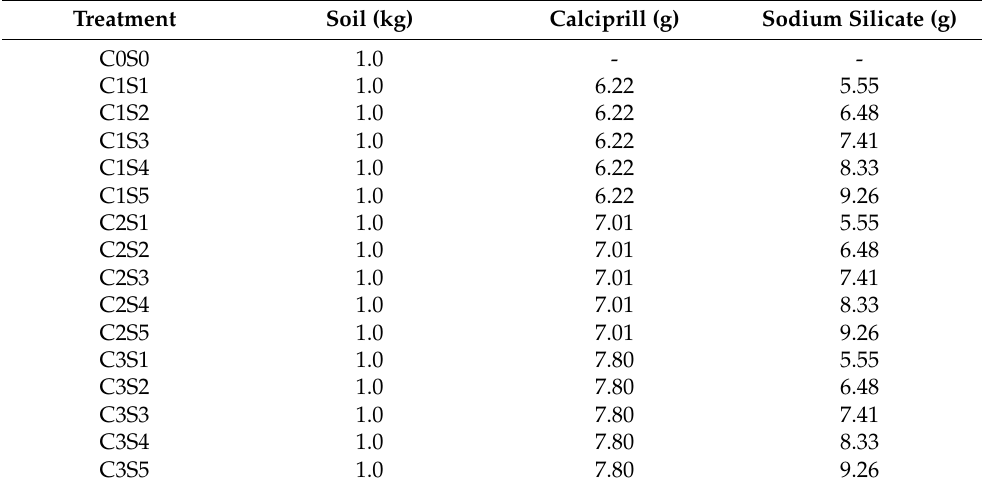
Table 1. Details on combined use of Calciprill and sodium silicate in the soil incubation study.